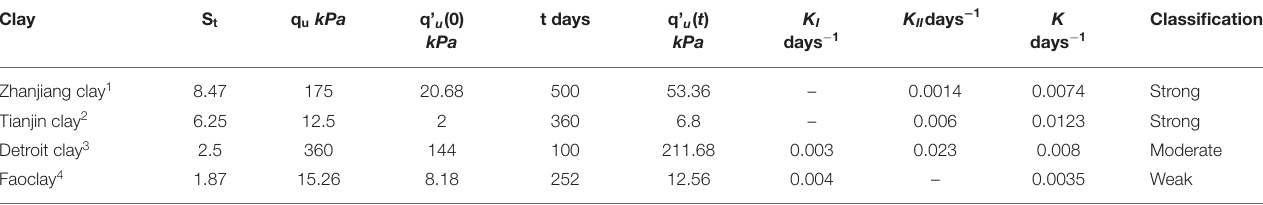
TABLE 5 | Classification of thixotropy of clays in different regions.